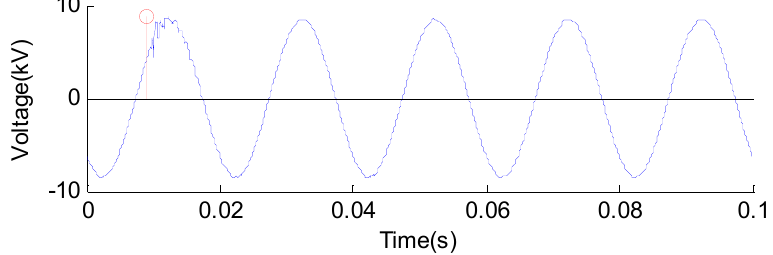
Figure 4. Location of extreme point in switching no-load line